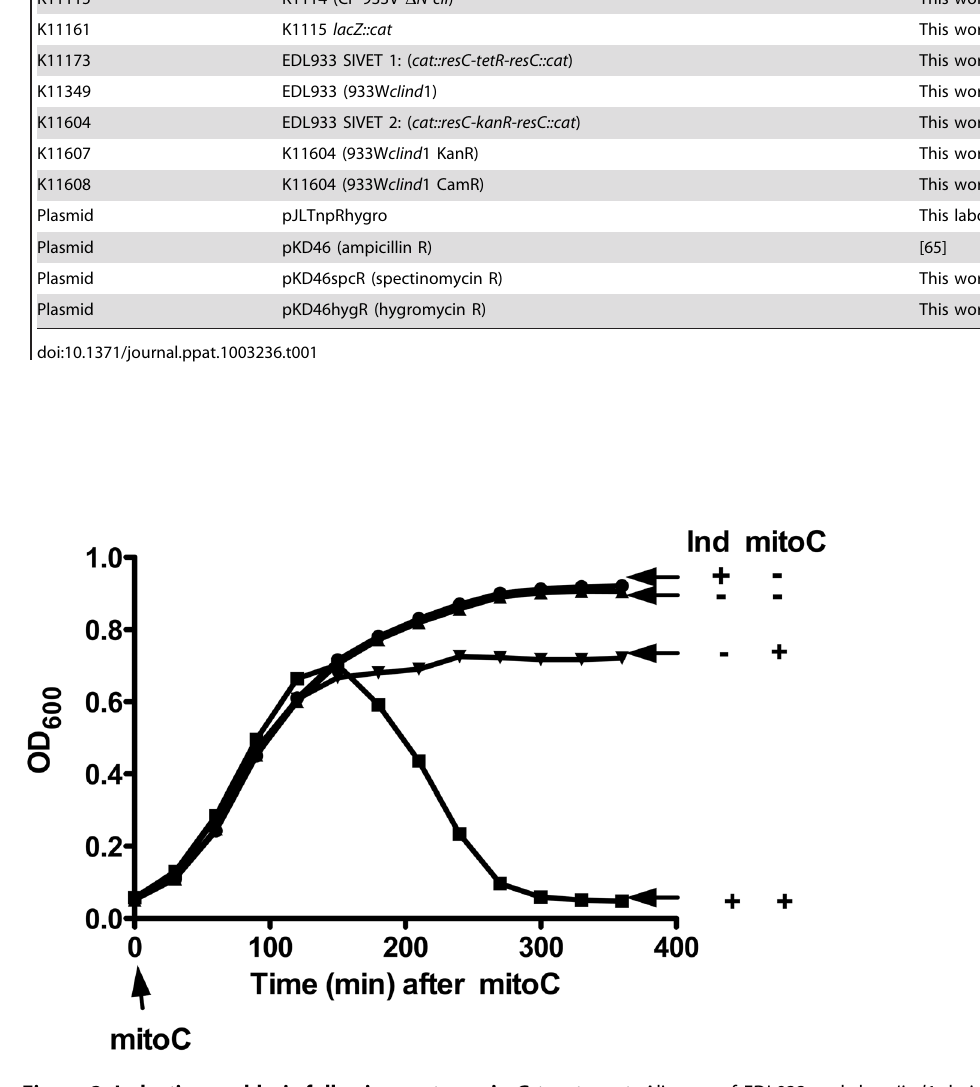
Figure 2. Induction and lysis following mytomycin C treatment. Aliquots of EDL933 and the cIind1 derivative untreated and treated with 2 m g/ml of mitomycin C were incubated with shaking at 37 u . Ind: ( + ) EDL933, inducible, ( 2 ) EDL933 cIind1 (K11349), not inducible. Mitomycin C: ( + ) treated, ( 2 ) untreated. Vertical arrow indicates time mitomycin C added. doi:10.1371/journal.ppat.1003236.g002 PLOS Pathogens |